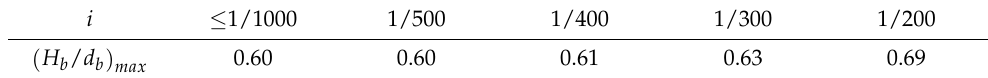
Table 8. Maximum ratio of breaking wave height to breaking water depth on gentle slopes. i ≤ 1/1000 1/500 1/400 1/300 1/200 ( H ) 0.60 0.60 0.61 0.63 0.69 b / d b max